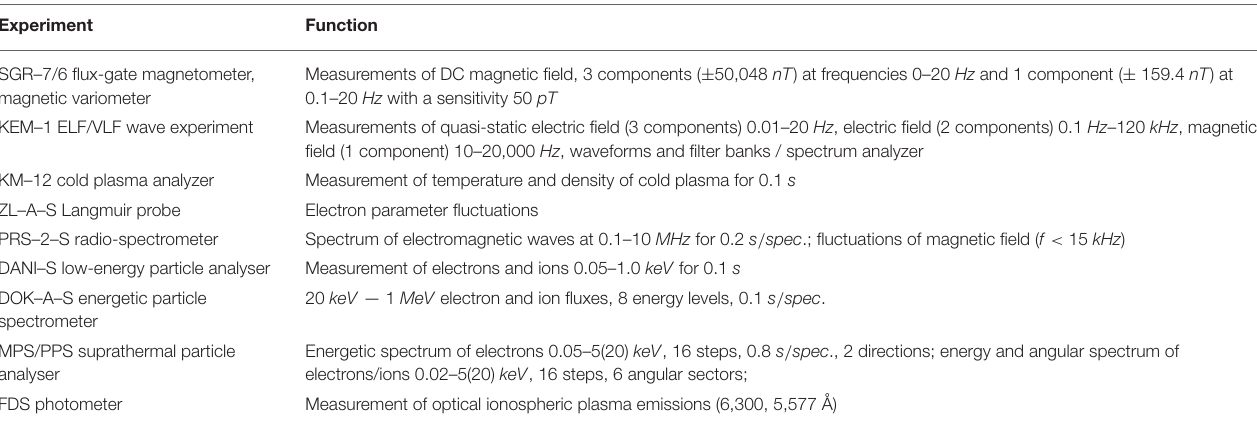
TABLE 2 | MAGION–3 scientific payload (Triska et al.,